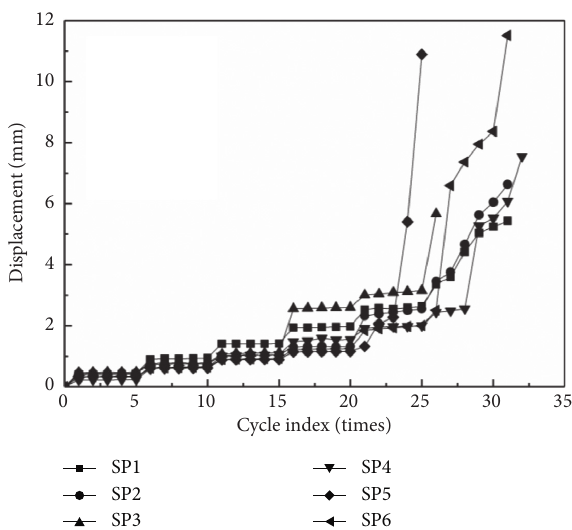
Figure 11: Cycle times and mid-span deflection curve.